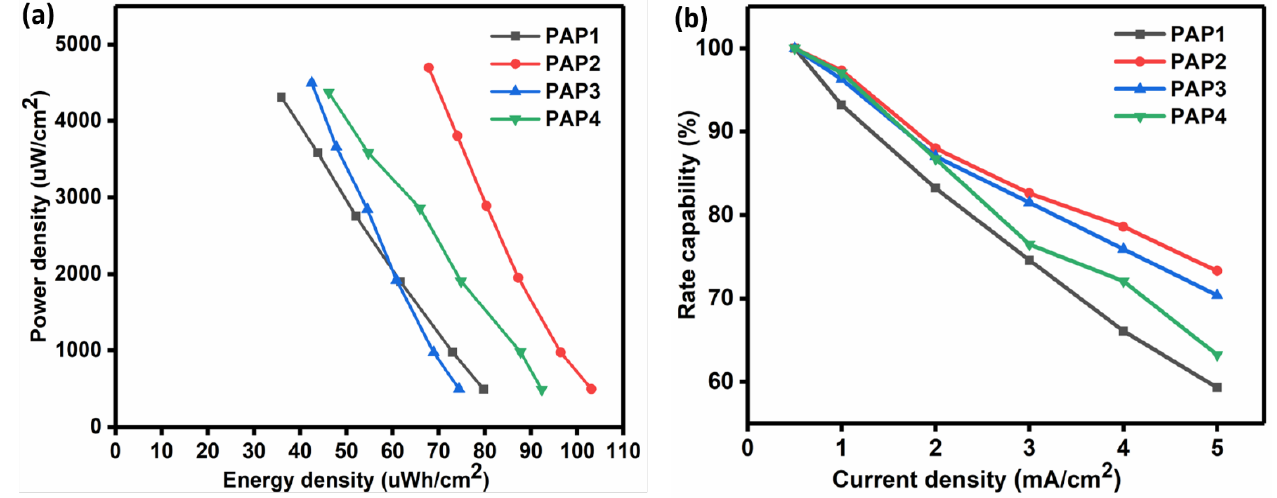
Figure 12. ( a ) Comparison of GCD curves at 0.5 mA/cm 2 , ( b ) areal capacitance vs. current density. Figure 13a represents the Ragone plot of the calculated power density versus the calculated energy density of all the samples. PAP2 delivered higher power density and energy density as compared to the other samples. By comparing PAP2 and PAP4, as both of them contain 3 mL Agar, we can see a clear difference in the energy density and power density. This difference is attributed to the in situ grown conducting polymer electrodes. The fact is that the best sample which is PAP2 contains 5mL of PANI and PPy each which improves the charge conductivity, while PAP4 contains 2.5 mL PANI and PPy each. Table 2 presents the maximum areal capacitance values, energy density, power density, and rate capability of all the samples that were obtained.